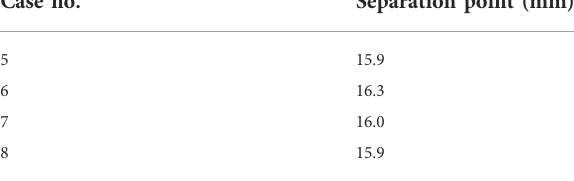
TABLE 4 Locations of the separation point and the thermal front for Cases 5 – 8. Case